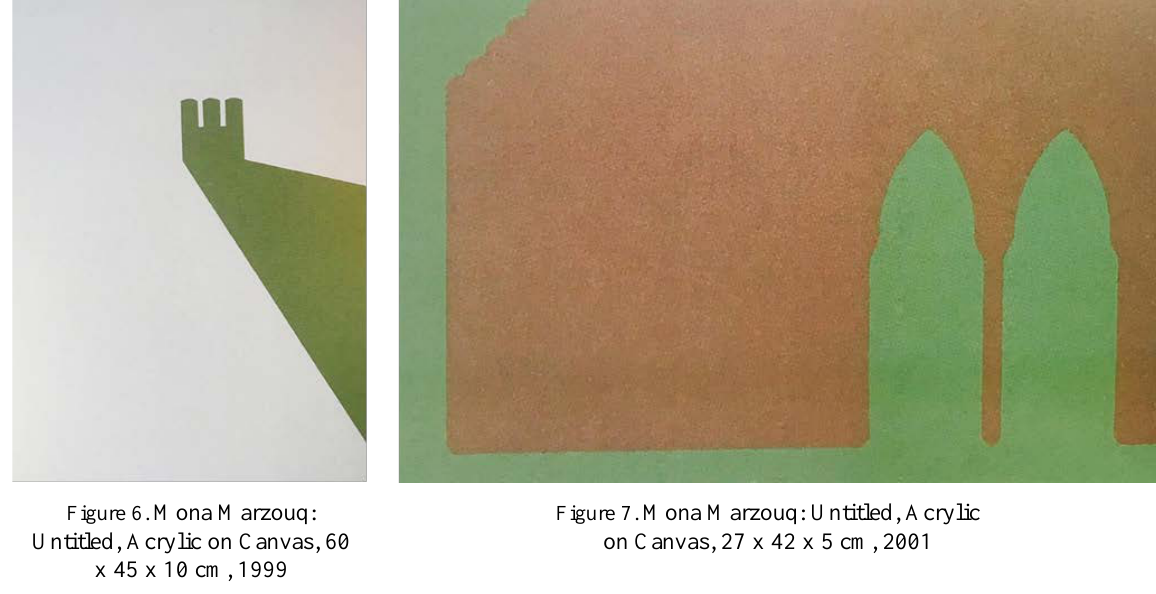
Figure 6. Mona Marzouq: Untitled, Acrylic on Canvas, 60